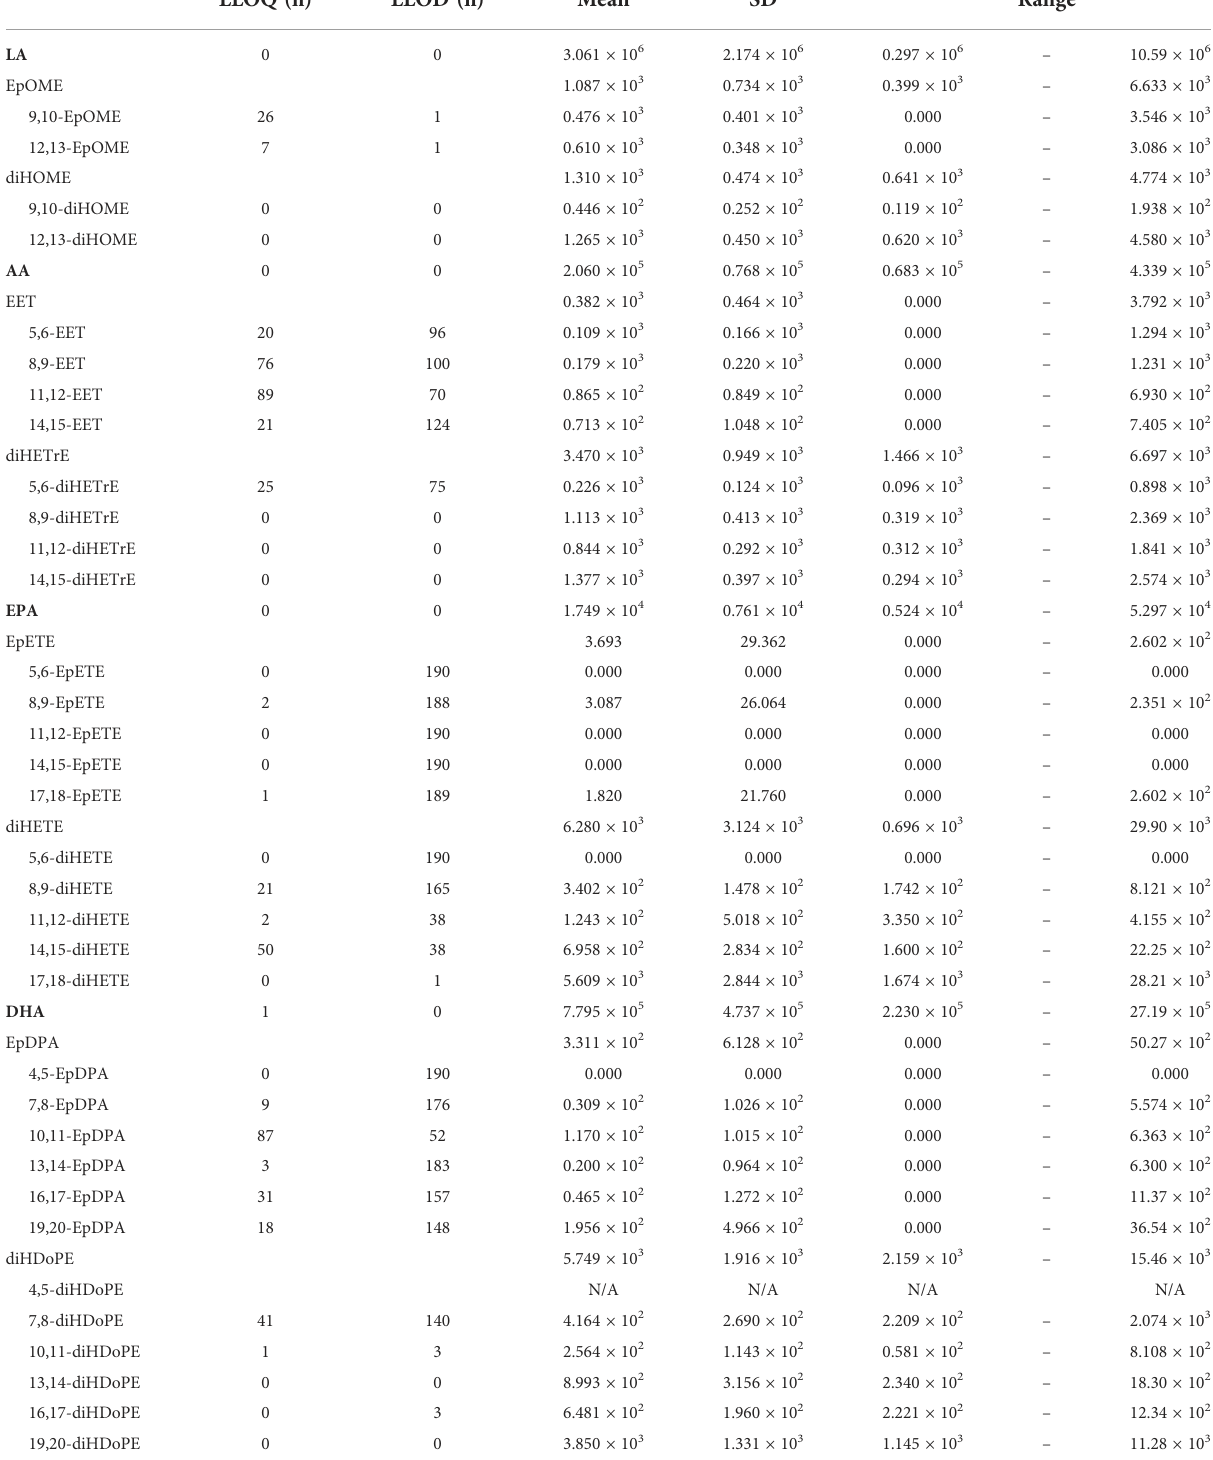
TABLE 2 PUFA metabolite pro fi le of cord